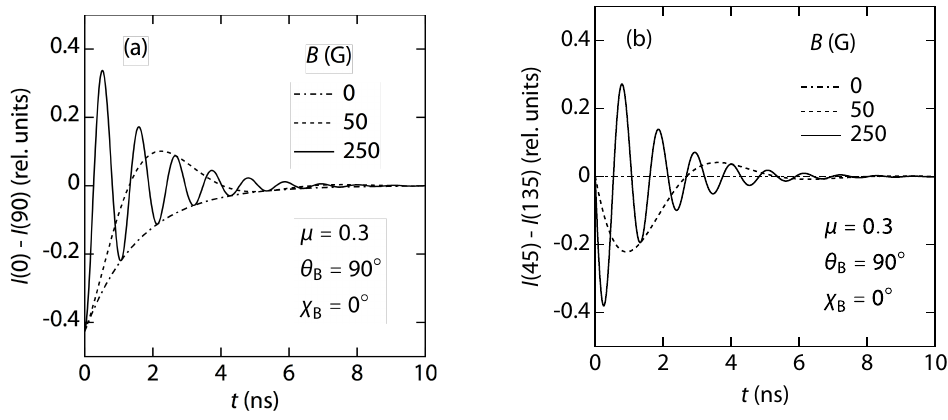
Figure 4. Temporal variation of ( a ) I ( 0 ) − I ( 90 ) and ( b ) I ( 45 ) − I ( 135 ) . Here, only the J = 3/2 level is taken into account as the upper state of the transition.